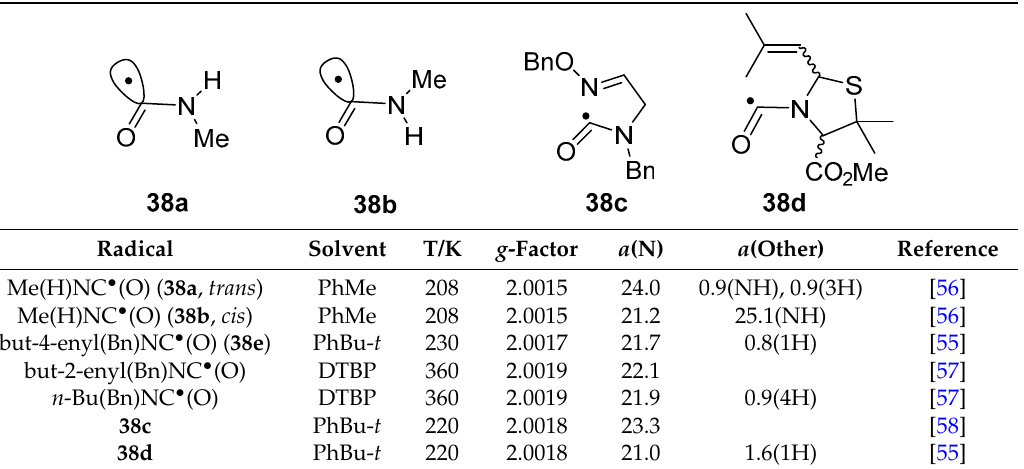
Molecules 2016 , 21 , 63 Table 3. EPR parameters of carbamoyl (aminoacyl) radicals in solution. Table 3. EPR parameters of carbamoyl (aminoacyl) radicals in solution. Table 3. EPR parameters of carbamoyl (aminoacyl) radicals in solution.